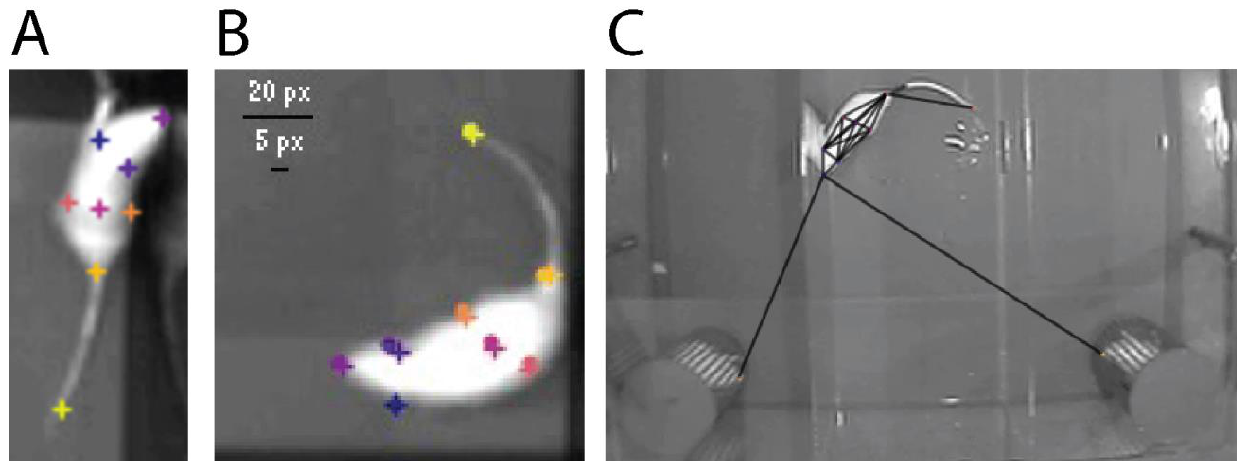
Figure 3. Automated animal tracking for nose-touch detection. Representative images of the training process produced in DeepLabCut are shown. ( A ) The 8 user-labeled body parts (nose, left and right ears, left and right flank, body center, tail base, and tail tip) are indicated on an image (+) used to train the model to identify each individual body part; ( B ) a test image showing the difference in placement between user-labeled body parts ( + ) and the location of the same body part ( • ) predicted by the model; ( C ) the final pose-estimation model demonstrating the automated body-part tracking in an experimental video where the noses of two stimulus animals are simultaneously tracked in relation to the body and nose of the experimental animal.